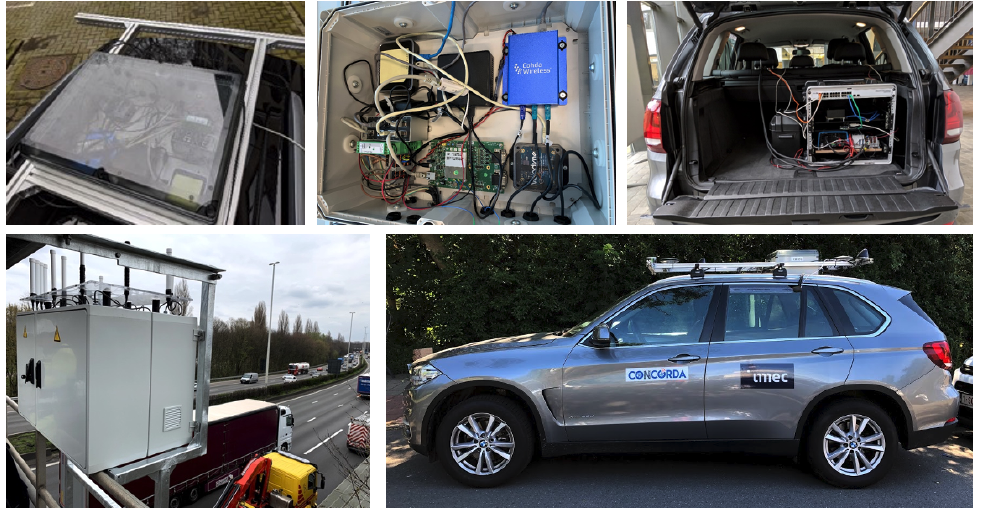
Figure 4. Vehicle and roadside infrastructure at the